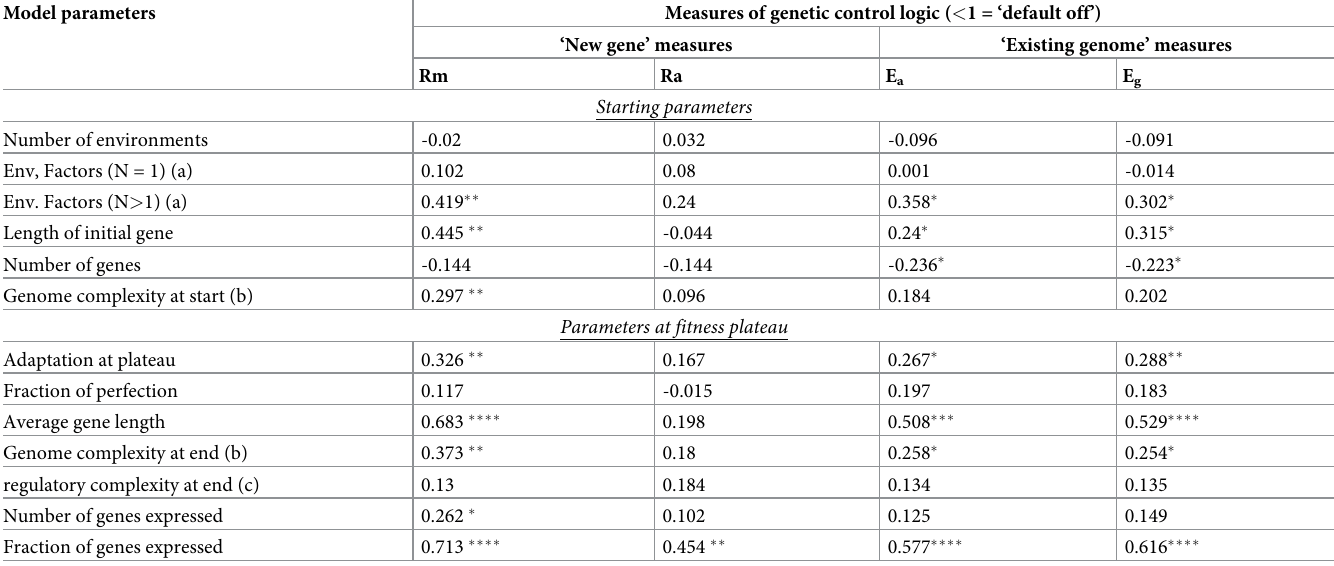
Table 1. Correlations with control logic